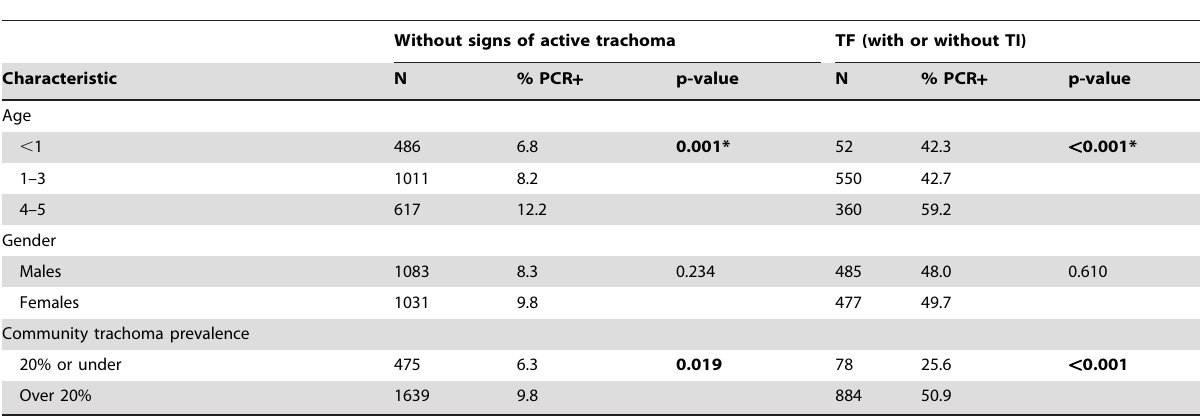
Table 3. Relationship between trachoma status and infection in children by demographic characteristics at baseline.